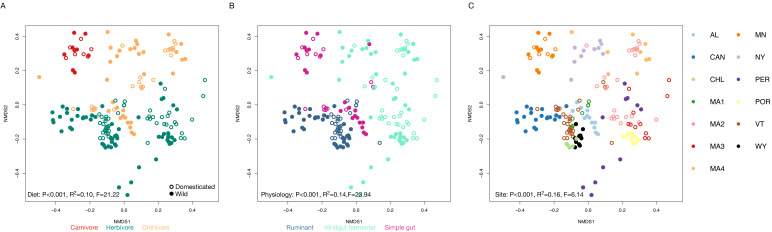
Alternative factors associated with gut microbiota variation among wild and domesticated mammals.Diet type (A), digestive physiology (B), and collection locale (C) are significantly associated (permutational MANOVAs) with variation in microbial community composition among wild and domesticated mammals, visualized here with nonmetric multidimensional scaling (NMDS) ordination of Bray–Curtis dissimilarity. Site abbreviations are as listed in 'Materials and methods'.